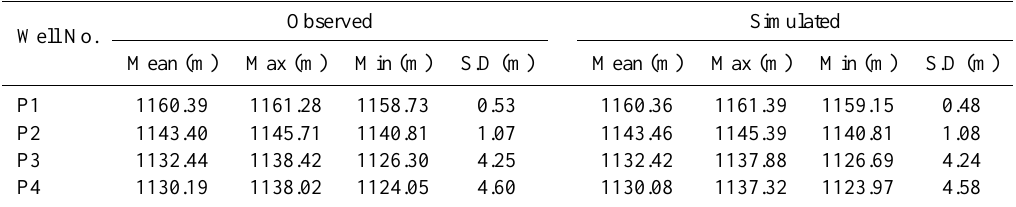
Table 3. Statistics for observed and simulated values for all observation wells (P1 to P4) in all unsteady-state model periods between 1993 and 2007.